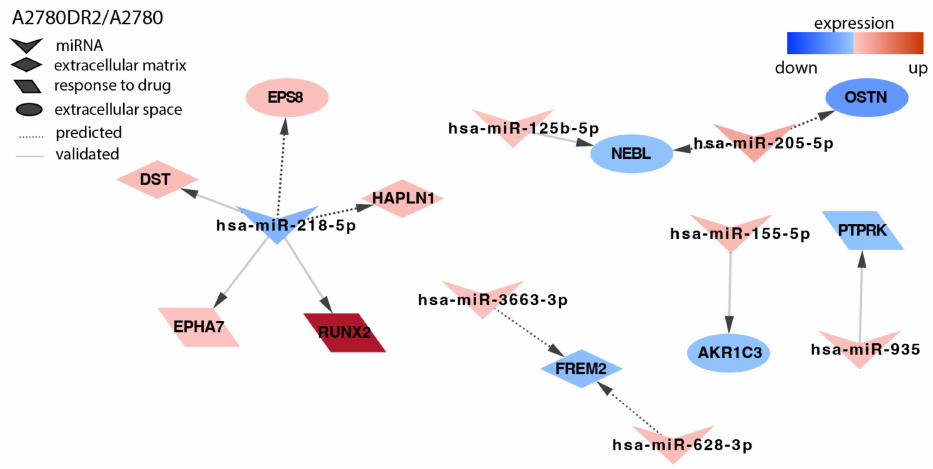
Figure 4. Regulation of selected target genes by miRNAs in the A2780DR2 cell line.